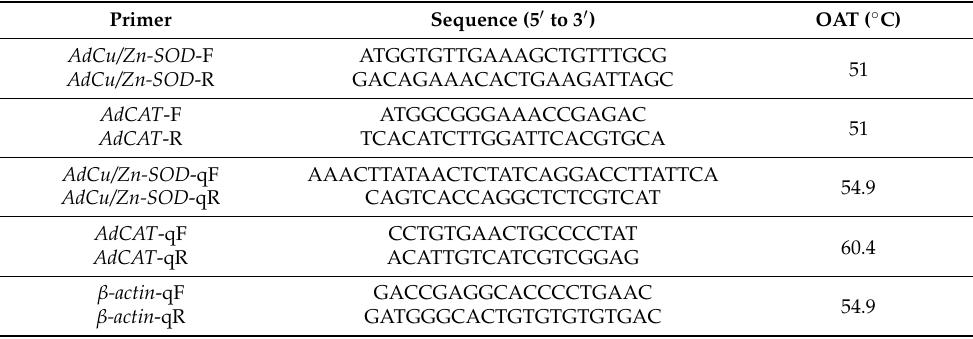
Table 1. PCR primers and optimal annealing temperatures (OATs) used for cloning and gene expression